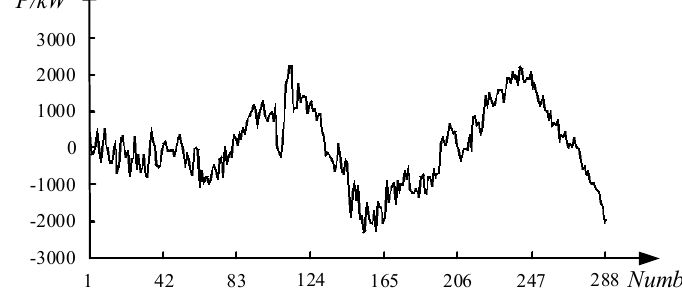
. Figure 4. Ideal power value of the hybrid energy storage systems (HESS), P ∗ HESS HESS . HESS